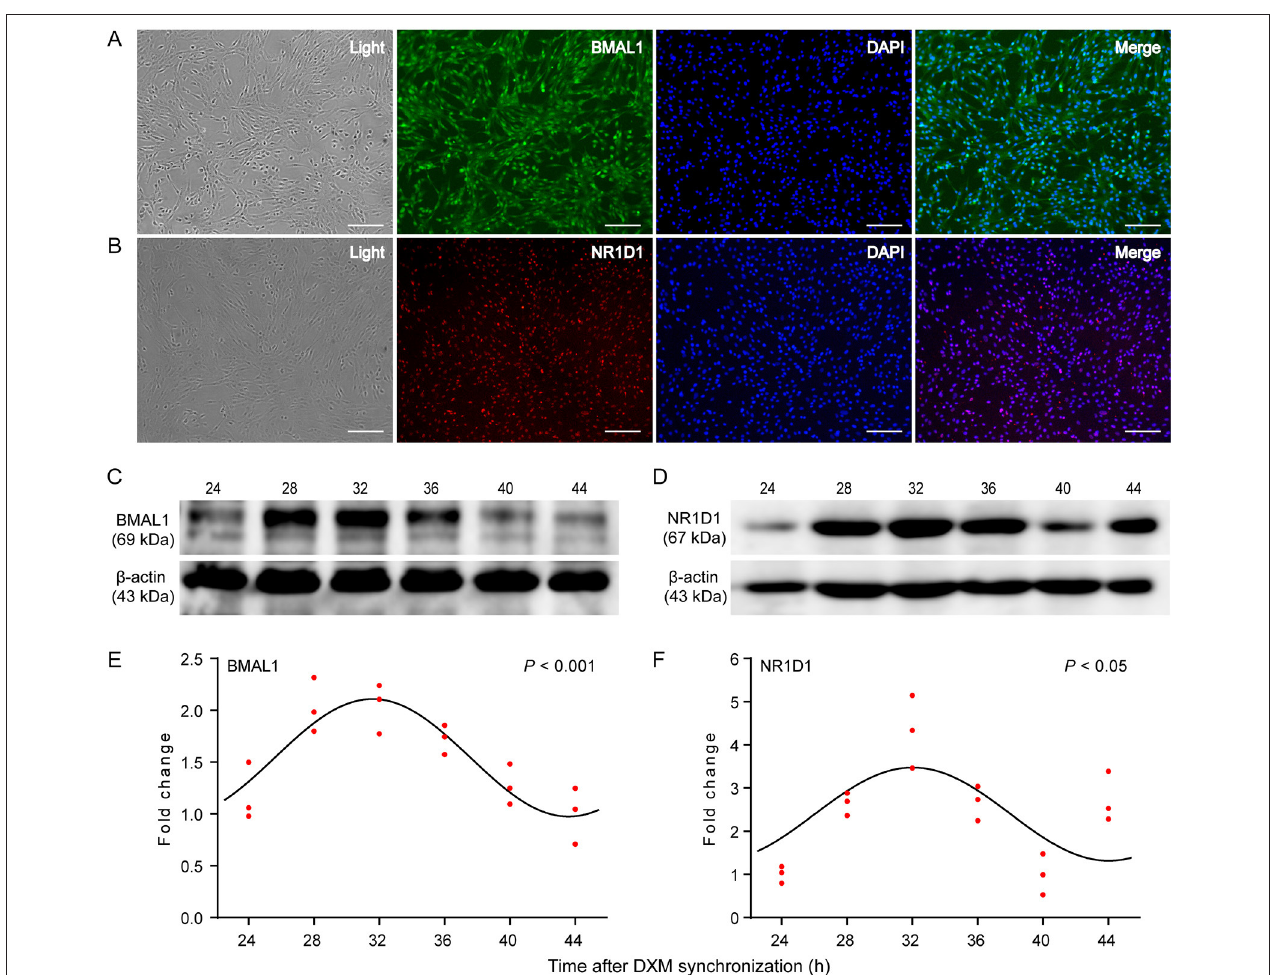
FIGURE 3 | Expression patterns of the circadian clock proteins in GEFs. Third-generation GEFs were used for cell immunofluorescence staining. After culture for 2 days, the attached GEFs were subjected to fluorescent immunocytochemistry using anti-BMAL1 (green, A ) and anti-NR1D1 (red, B ) antibodies. Scale bar, 50 µ m. Total proteins were extracted from the GEFs and collected at the indicated times following DXM synchronization. The protein levels of BMAL1 (C) and NR1D1 (D) were analyzed by western blotting analysis. The ratio of BMAL1 (E) or NR1D1 (F) protein to β -actin was determined from the densities of the immunoreactive bands and expressed as relative to the nadir. Red dots represent the relative values of each independent determination at the respective time points ( n = 3). Cosinor analysis was utilized to determine the rhythmic expression patterns of the examined proteins. The black solid lines show the fitted curves. P < 0.05 was considered to indicate rhythmic expression. GEFs, goat embryonic